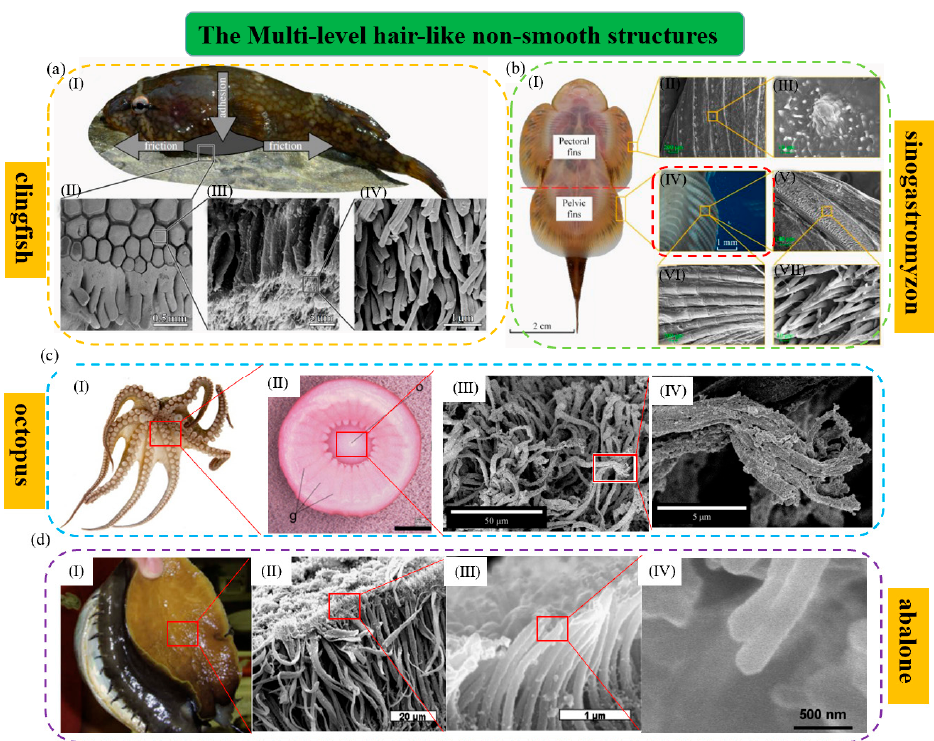
Figure 2. The multi − level hair − like structures of typical aquatic organisms. ( a ) The suction cup of the clingfish (reproduced with permission from [83], the Royal Society, Copyright 2013): (I) The clingfish attaches to a rock surface; (II) SEM image of the ventral surface of the attached suction cup. edge of the suction cup and other points of the surface; (III) SEM image of a papilla. The papilla consists of lots of rods that are subdivided apically into many fine filaments; (IV) SEM image of the filaments on the tips of the rod − like structures. ( b ) Microstructural characterization of Sinogas- tromyzon szechuanensis observed with SEM (reproduced with permission from [15], Cong Qian et al.,